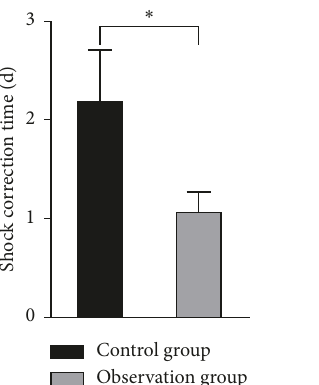
Figure 6: Comparison of the shock correction time between the two groups. Note: compared with the control group,